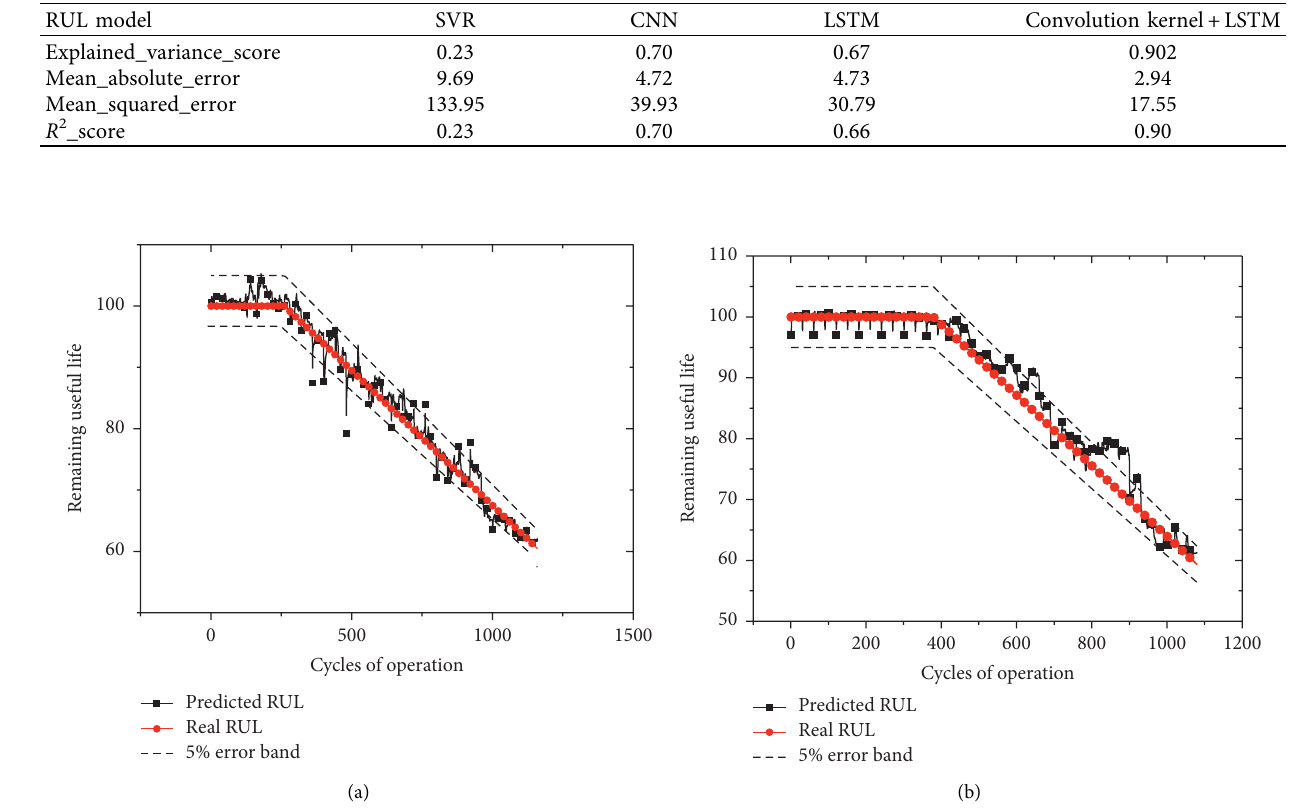
Table 5: Average test losses of different RUL prediction models.